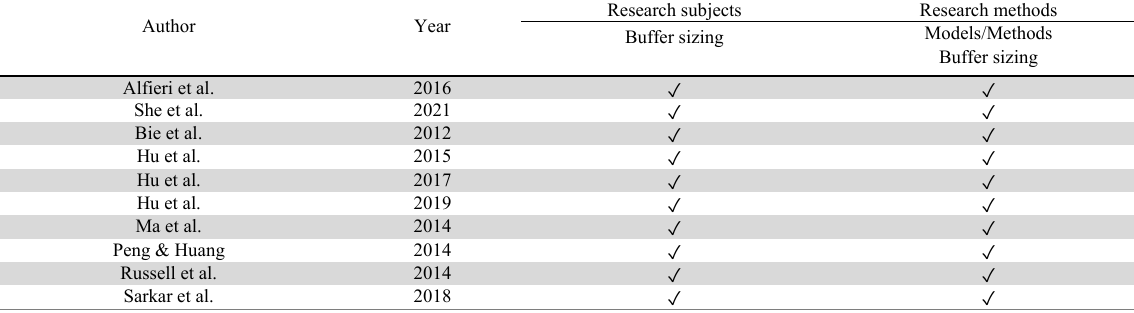
Project buffer sizing: Algorithms/models Author Year